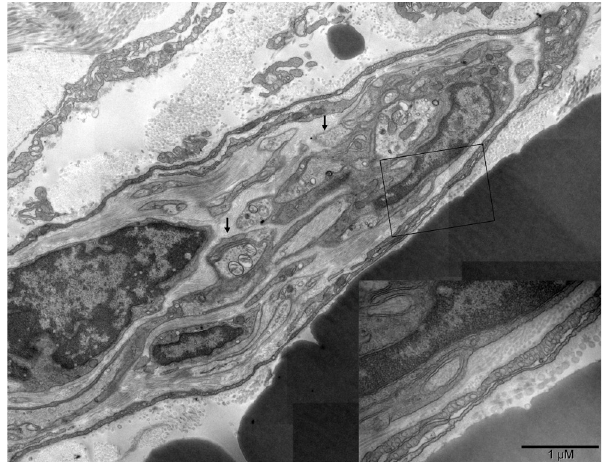
Figure 14. Developing peripheral nerve. Several nerve fibers were engulfed by Schwann cells on the right but progressing myelination could be recognized only on the one in the center with three mitochondria in the section plane (left arrow). Multiple nerve boutons with synaptic vesicles (right arrow) were present but mature synapses were absent. Surrounding the nerve fibers was one to three-layer neurothelium with abundant caveolae (insert in the right lower corner). Collagen fibers located internally were thinner (20–40 nm) than those lining the external surface of the neurothelium (60–100 nm). A giant erythroschizosome was located next to the forming nerve and it had similar dimensions (right lower corner behind the insert).